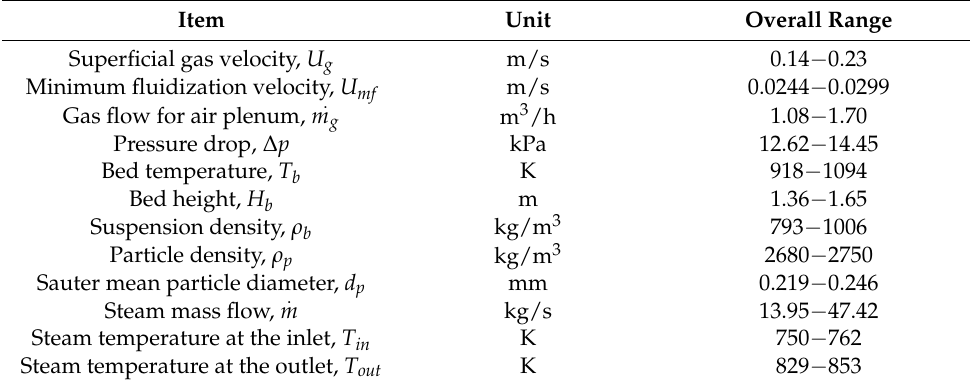
Table 4. Experimental conditions during performance tests in